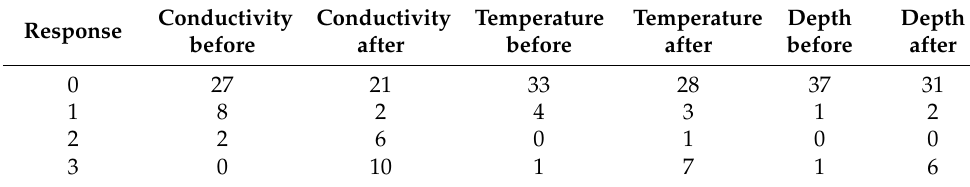
Table 6. Student scored open response assessment (CTD).